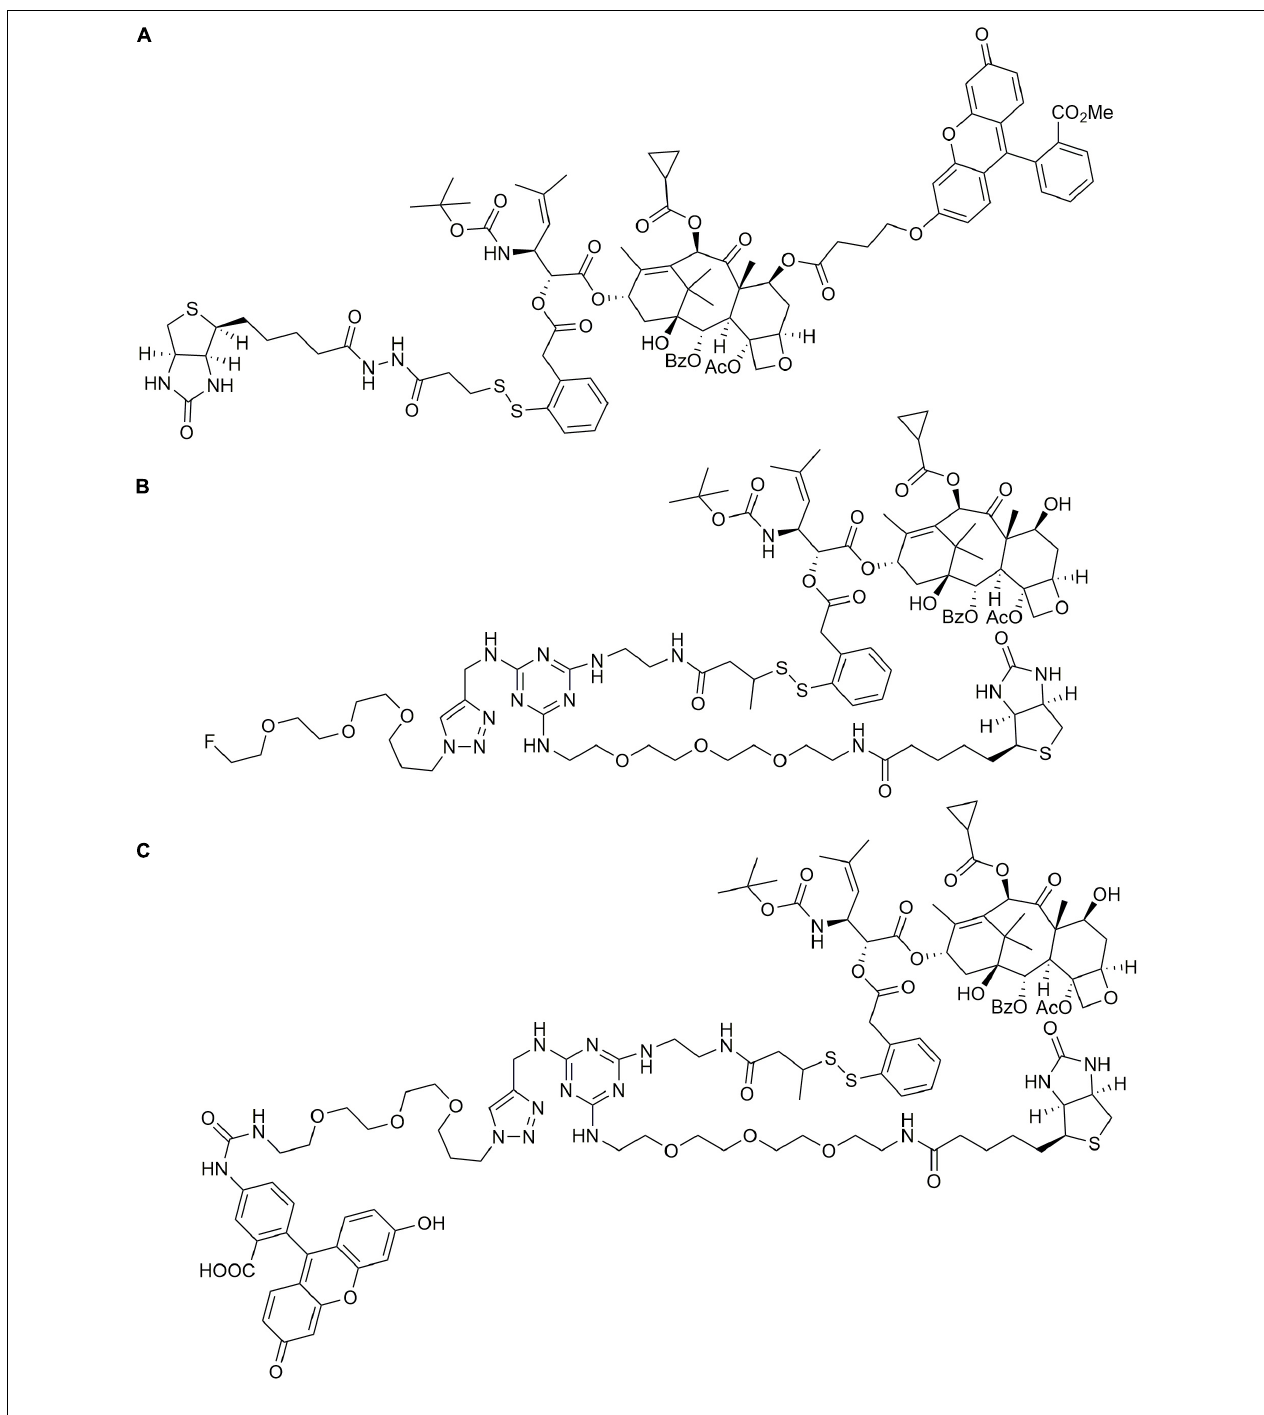
FIGURE 5 | The structures of three biotin–PTX